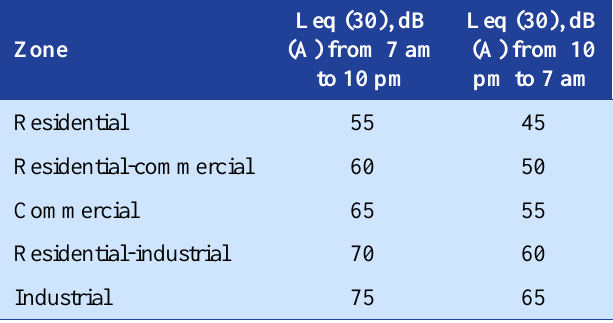
Table 2. Iran National Sound Standard at Ambient Air